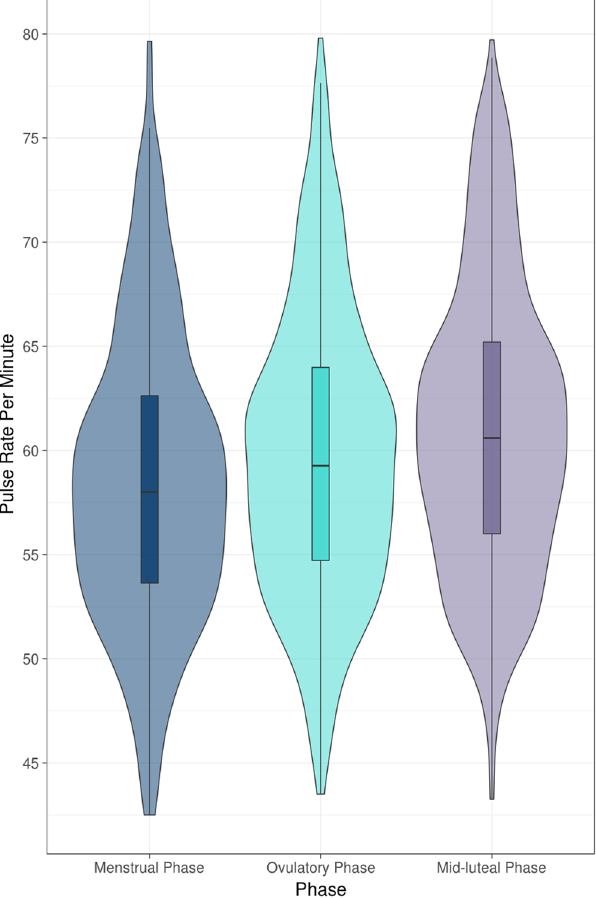
Figure 1. Violin plot of the pulse rate in the different phases of the menstrual